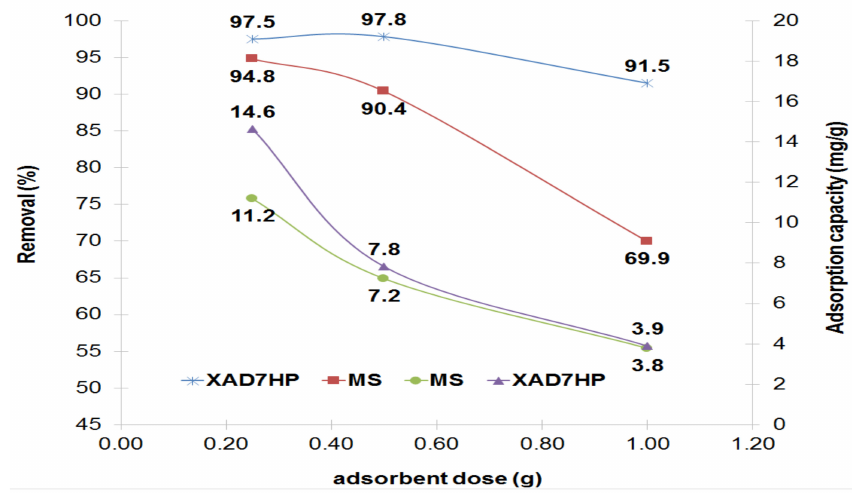
Figure 2. Effect of MS and XAD7HP dosage on AB 113 removal, Ci = 100 mg/L AB 113, pH = 8.04 for MS supernatant and pH = 7.83 for XAD7HP.